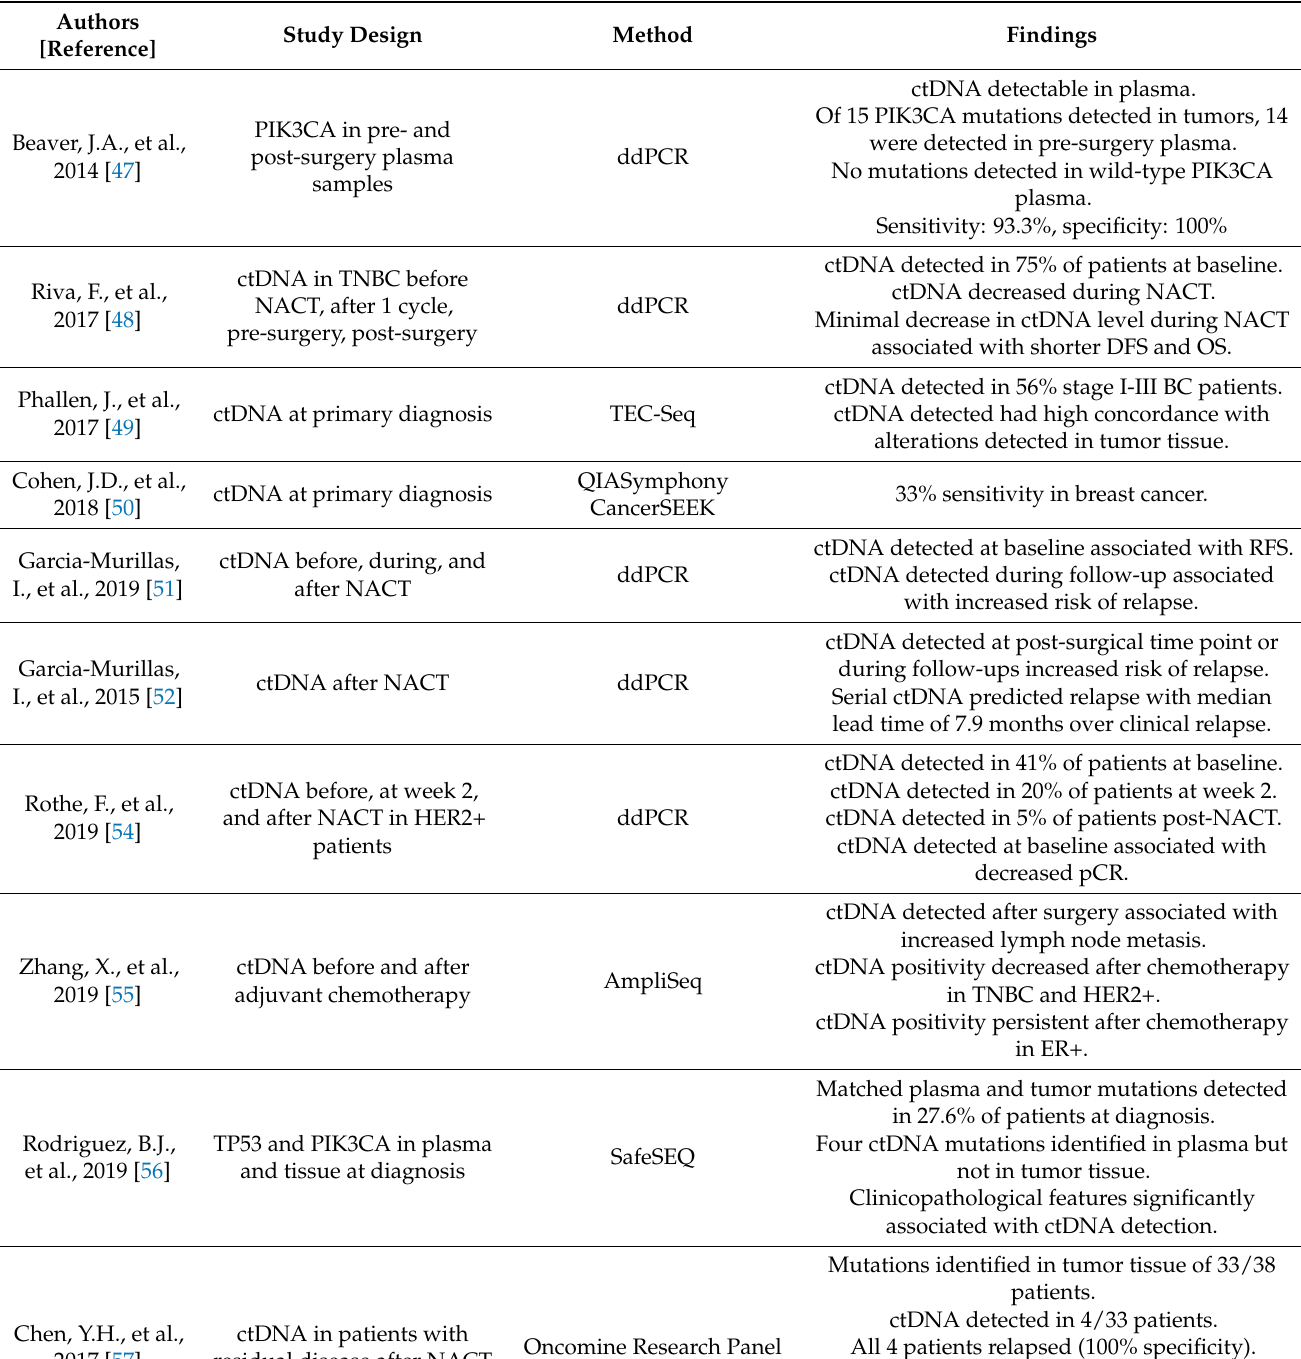
Table 2. ctDNA in early breast